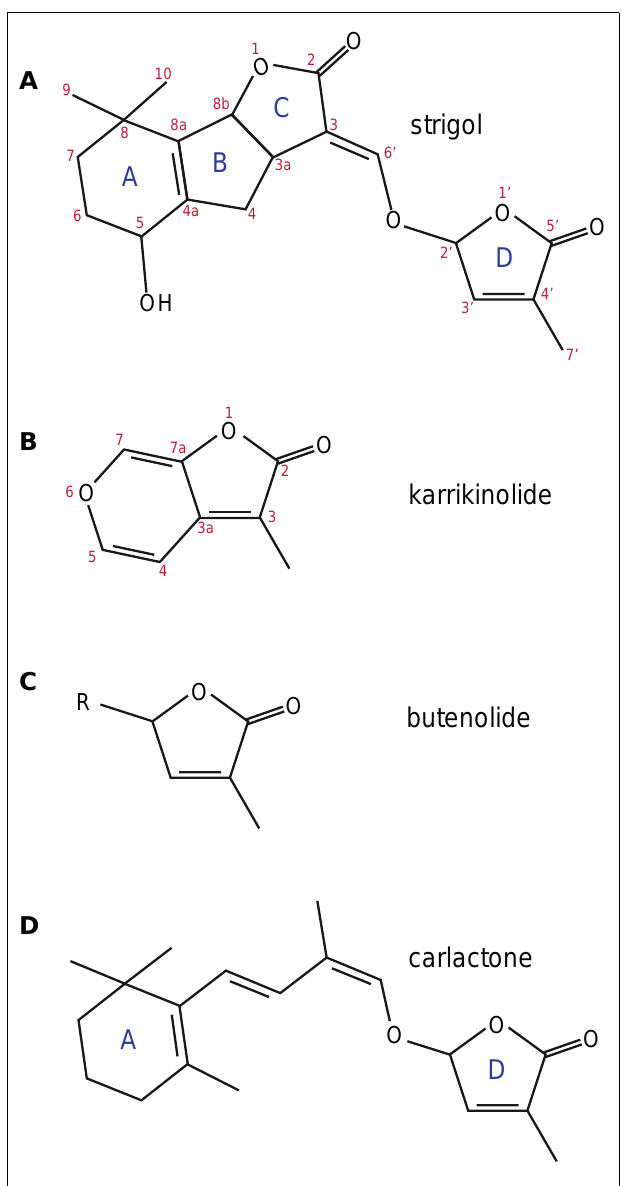
FIGURE 1 |The structures of strigol (A); karrikinolide, KAR 1 (B); the butenolide ring (C); and carlactone (D). The standard lettering of the ring structure in SL is shown as is the standard atom numbering for strigol and